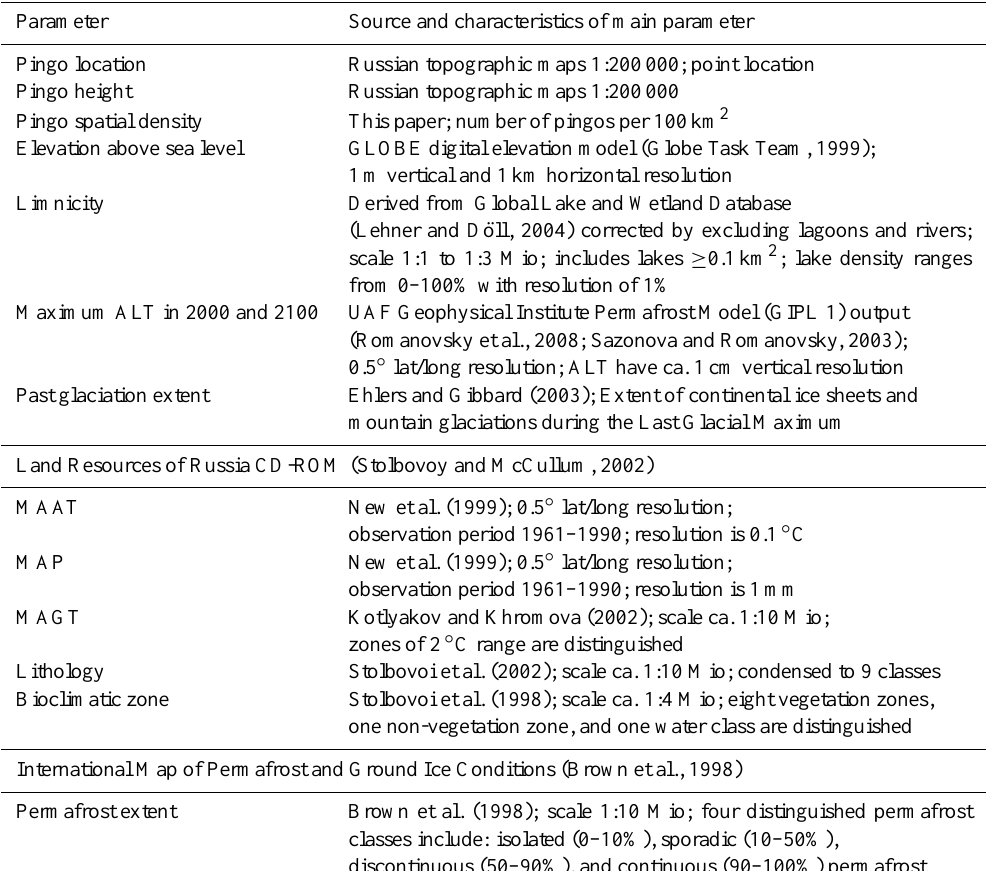
Table 2. Various datasets analysed in relation to identified pingos. Parameter Source and characteristics of main parameter Pingo